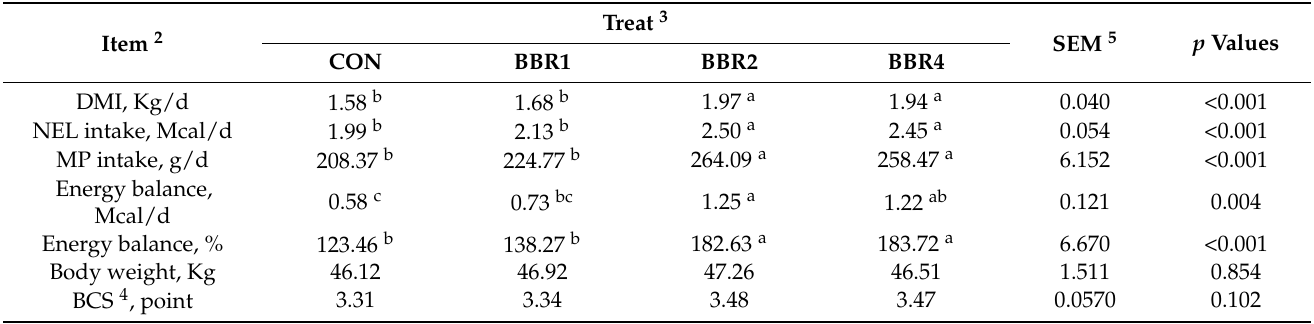
Table 2. Effect of Berberine (BBR) supplementation on intakes of dry matter (DMI), net energy for lactation (NEL), and metabolizable protein (MP) and body condition score (BCS) of transition dairy Saanen goats 1